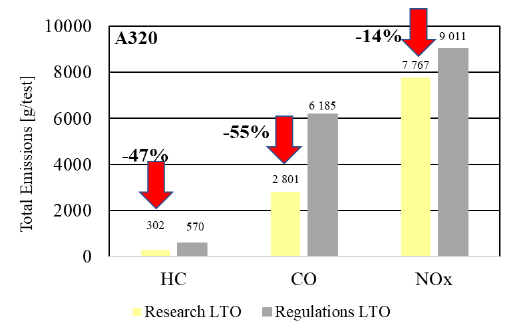
Fig. 15. Total emission of toxic exhaust fumes for adopted and regulations LTO for A320